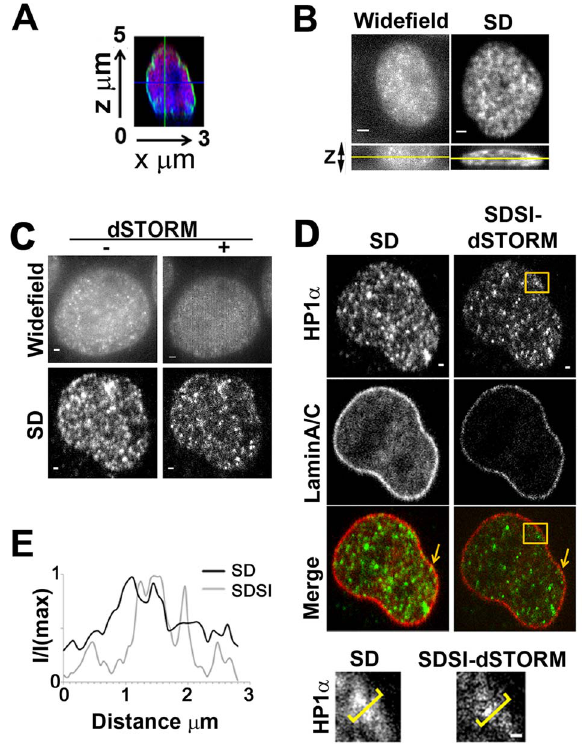
Figure 5. Multispectral super-resolution imaging of the nucle- us. (A) Point scanned confocal images showing orthogonal axial (x,z) view of Histone H3 (Red), LaminA/C (Green) and Nuclei (Blue). (B) Wide- field epifluorescent (WF) and spinning disk (SD) x,y and x,z images. Yellow line in x,z images indicates the plane shown in the x,y image of hetero-chromatin in the nucleus visualised using HP1 a , bar=2 m m. (C) dSTORM images of hetero-chromatin in the nucleus visualised using HP1 a antibodies acquired by widefield epifluorescence (WF) and spinning disk confocal (SD). SR data from both WF and SD images was generated using 3 rd order SOFI, bar=1 m m. (D) Comparison of SD and SDSI images of hetero-chromatin visualised using HP1 a antibodies and the nuclear membrane visualised using LaminA/C antibodies. Secondary FAb fragment antibodies conjugated to AlexaFluor555 and 647 were used for dSTORM imaging, SR data was generated using 3 rd order SOFI, bar=1 m m. Lower panel shows high-resolution region (indicated by orange box in upper panel) of heterochromatin, bar=1 m m. (E) Intensity profiles, through regions indicated by yellow parenthesis in E, comparing SD resolution with